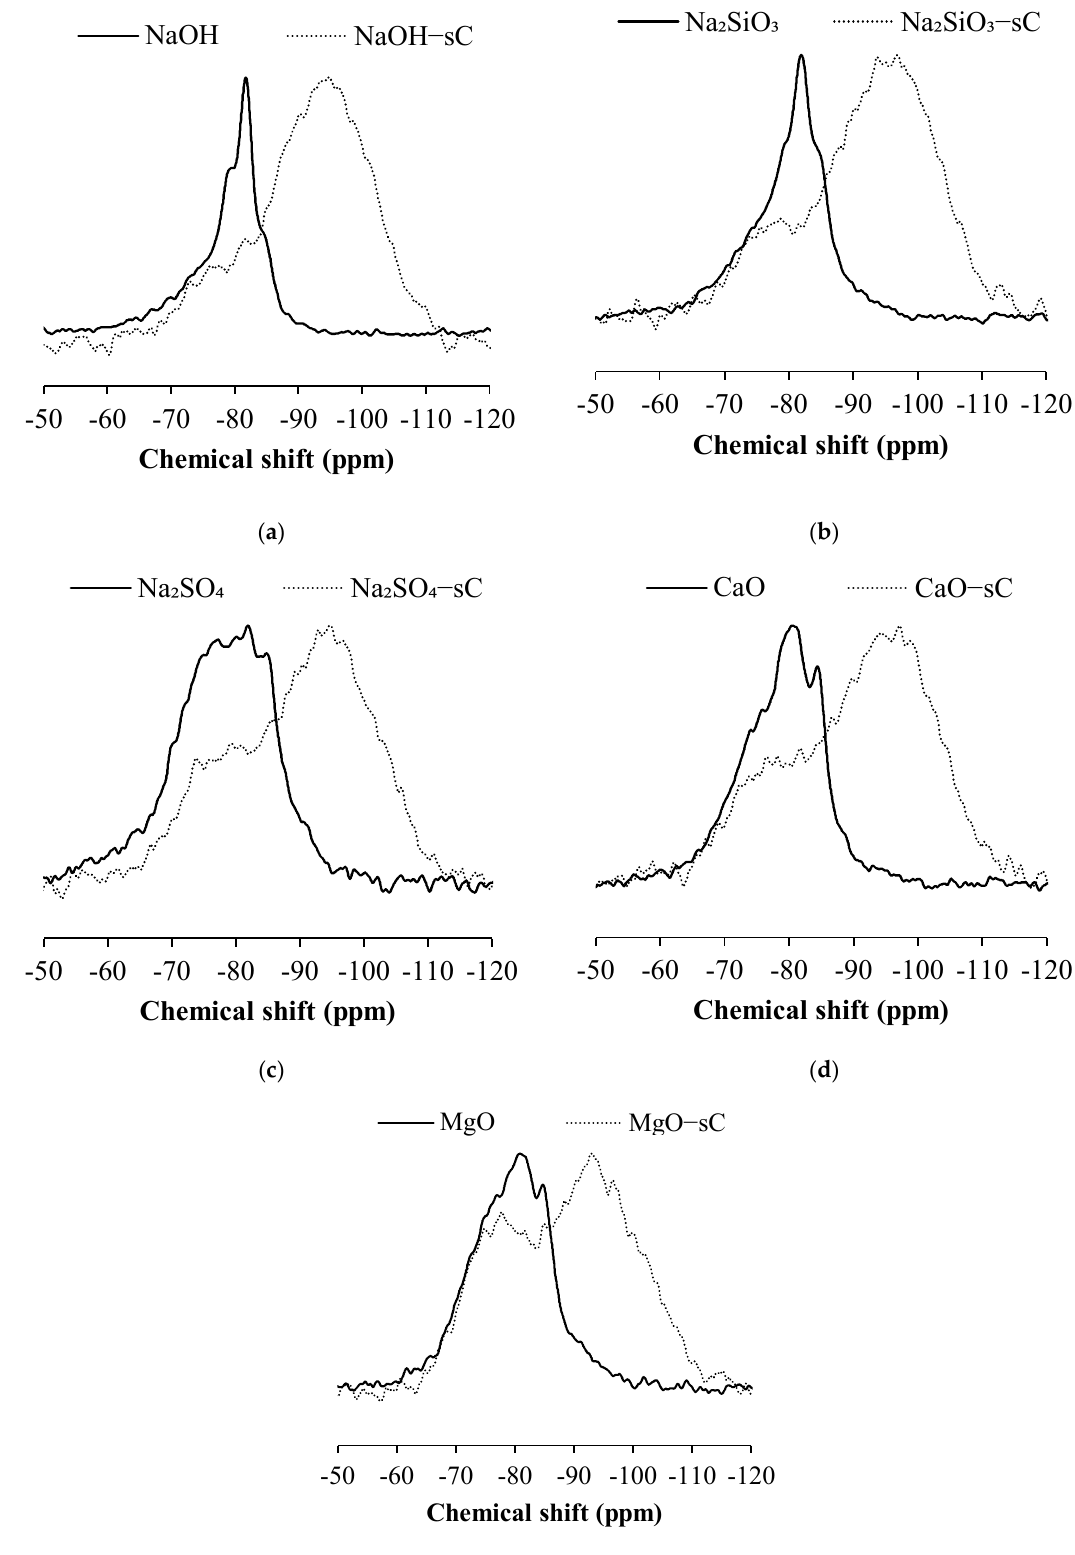
Figure 3. 29 Si MAS NMR spectra of activated slag before and after being exposed to sCO 2 . ( a ) NaOH ( b ) Na 2 SiO 3 ( c ) Na 2 SO 4 ( d ) CaO ( e ) MgO. The samples exposed to sCO 2 are shown in dotted